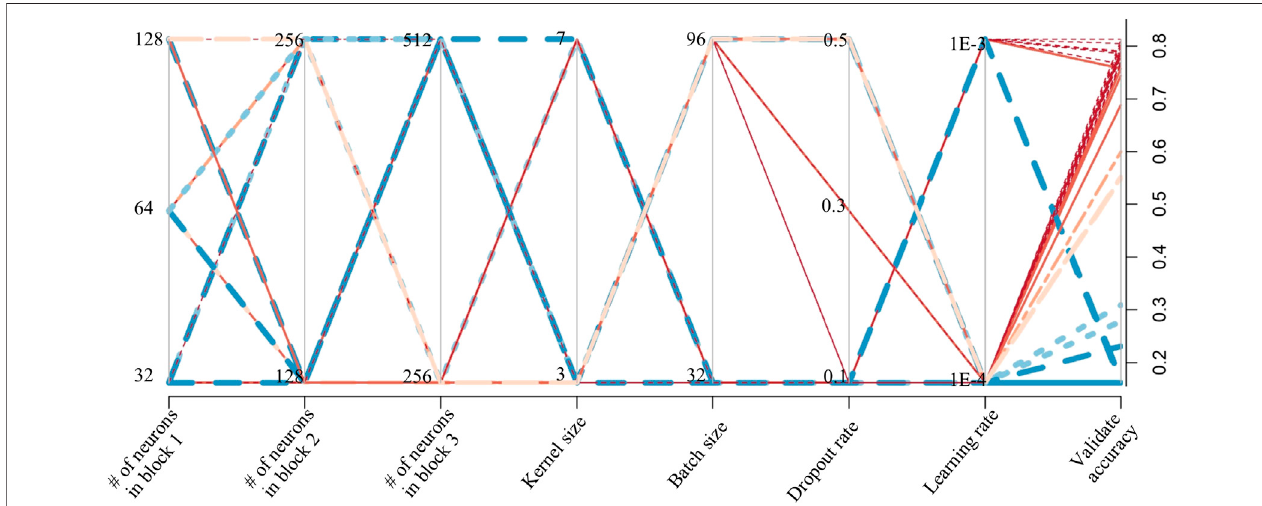
FIGURE 4 | Hyperparameter optimization chart. The warm-colored lines represent the model con fi gurations with higher validation accuracy, and the cool-colored lines are the model con fi gurations with lower validation